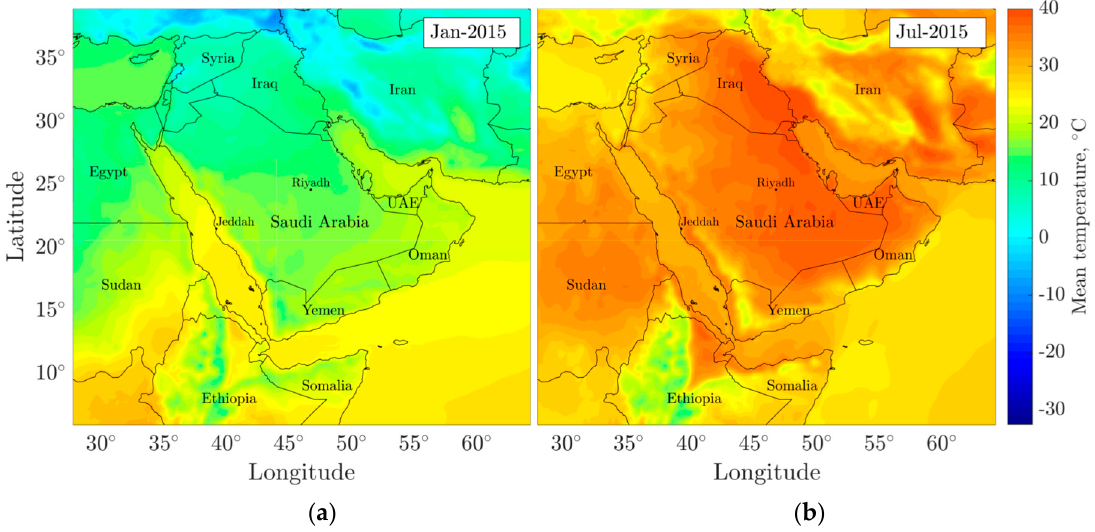
Figure 7. Monthly mean of daily temperature means in Saudi Arabia (2015). ( a ) January ( b ) July Source: Authors based on ECMWF ERA5.